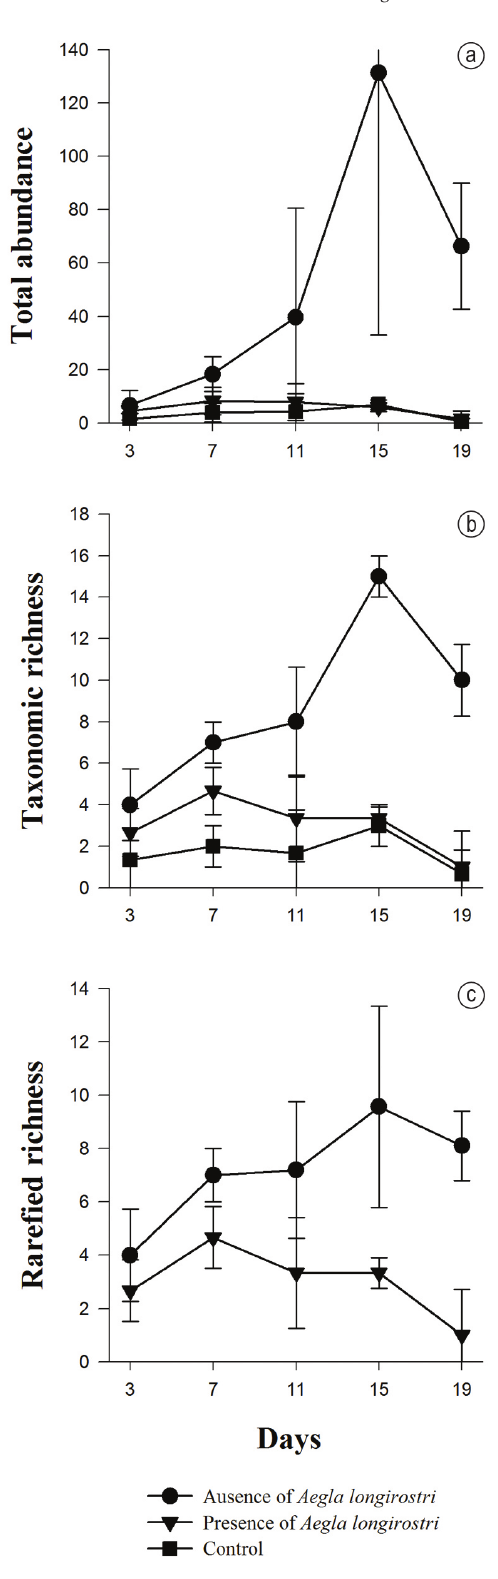
Figure 2. Total abundance (a), taxonomic richness (b) and rarefied richness (c) of aquatic invertebrates in the presence and absence of A. longirostri in leaves exposed 3, 7, 11, 15 and 19 to the stream. The bars indicate the standard